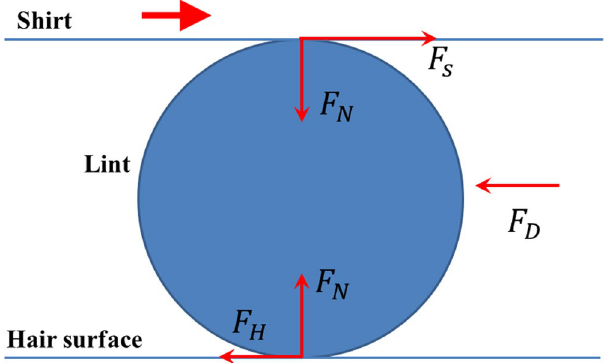
Figure 3. Cross-sectional view (represented by the circle) of the lint showing the different forces acting on it. Note that since the fabric is moving rightward, the frictional force exerted by the lint on the fabric will be leftward. Consequently, the frictional force exerted by the fabric on the lint will be rightward as shown by the arrow marked F . Similarly, at the hair-lint interface since the motion of the lint with respect to the hair is S rightward, the frictional force F exerted by the hair on the lint will be H